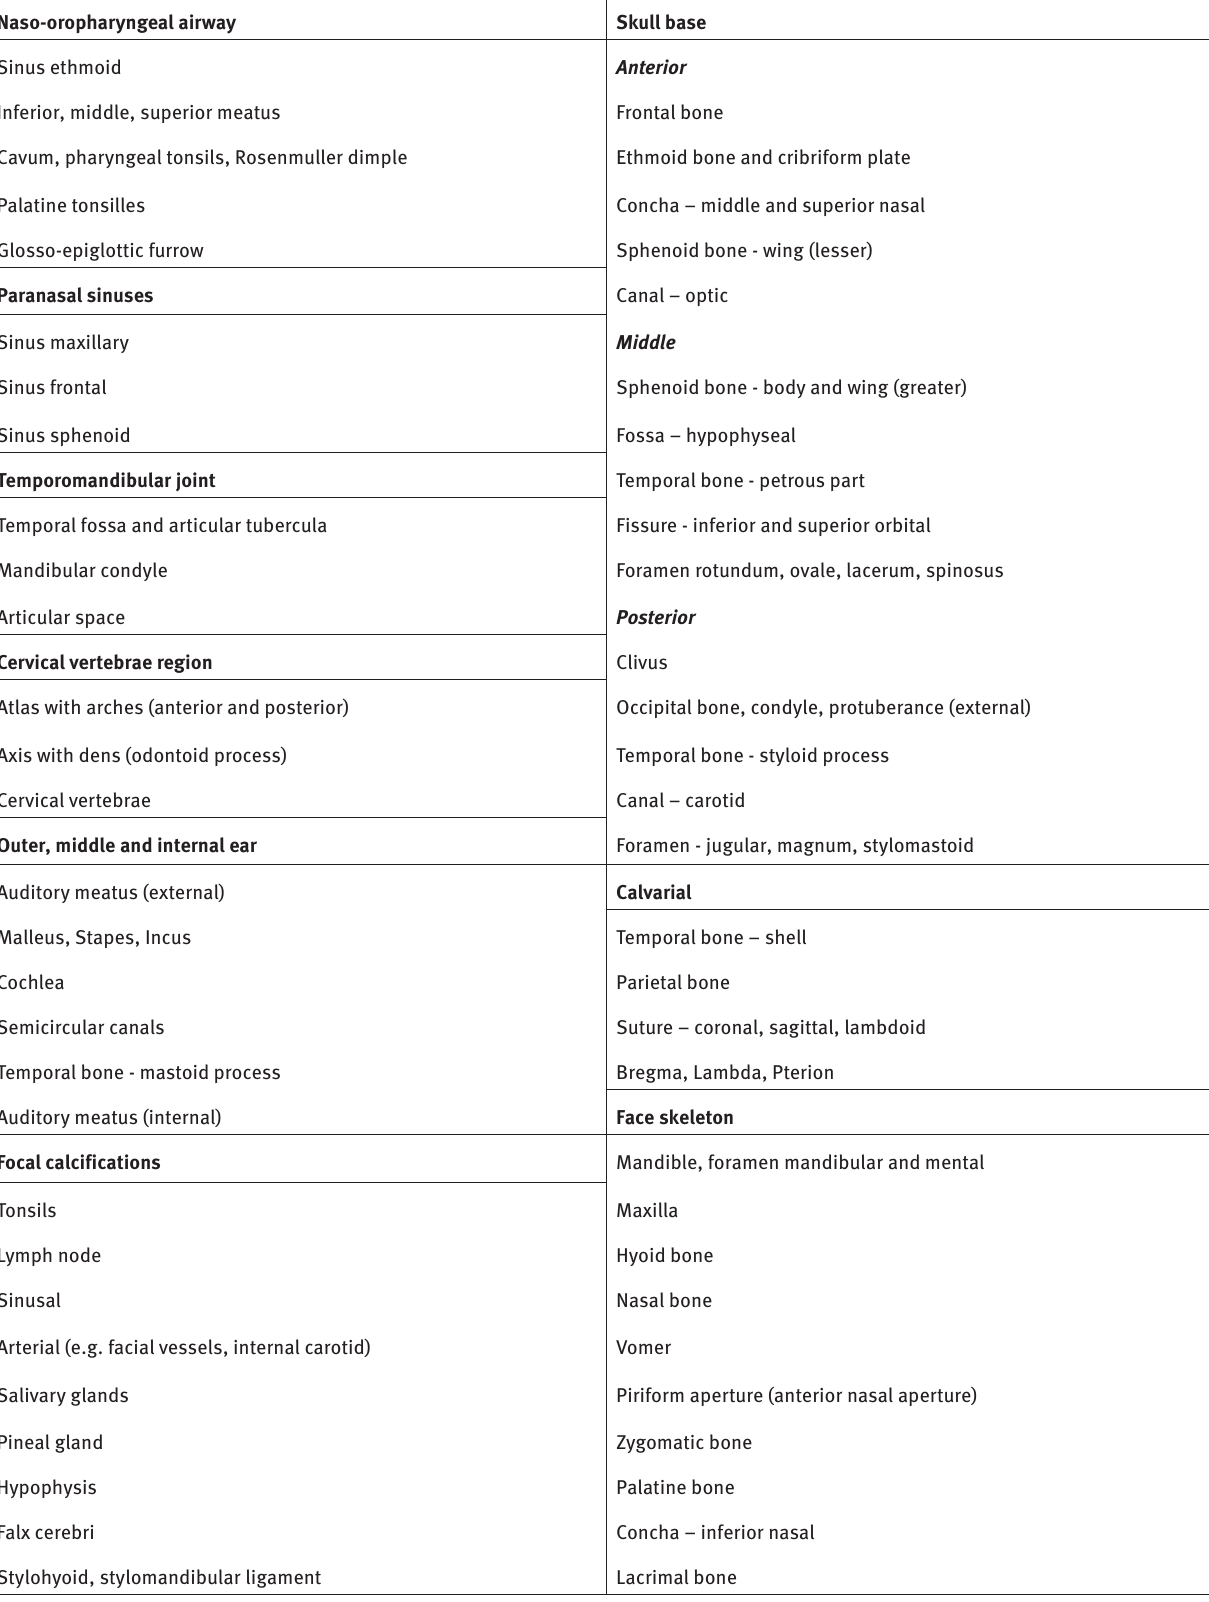
Table 1 : List of bone structures and spaces of head and neck in CBCT imaging (depending on field of view size) Naso-oropharyngeal